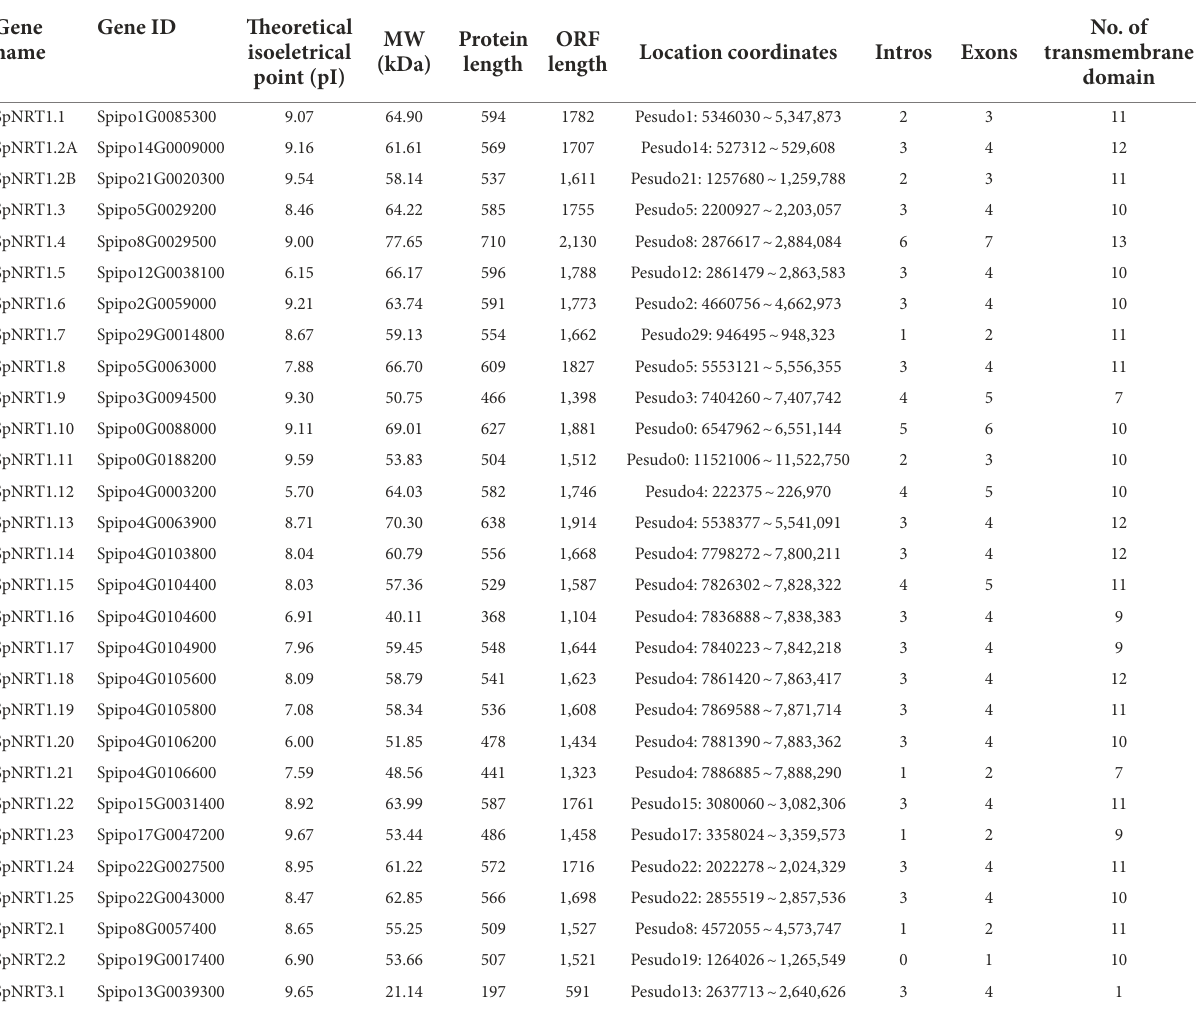
TABLE 1 Basic information of SpNRT genes.